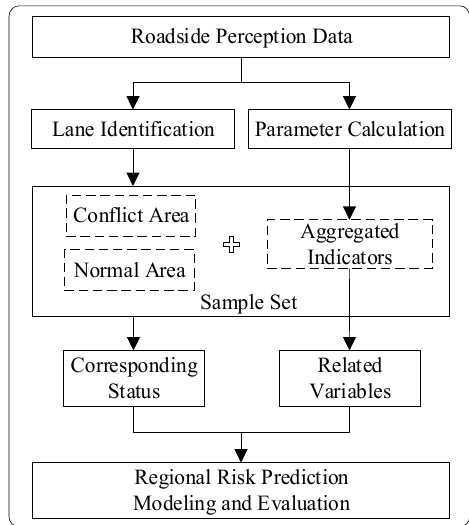
Figure 1. The overall framework of this study.